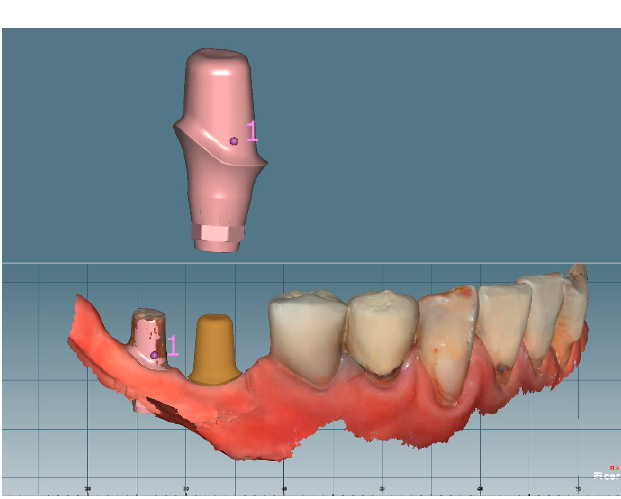
Figure 3. Image overlapping and replacement of the abutment design with the intraoral scan data.